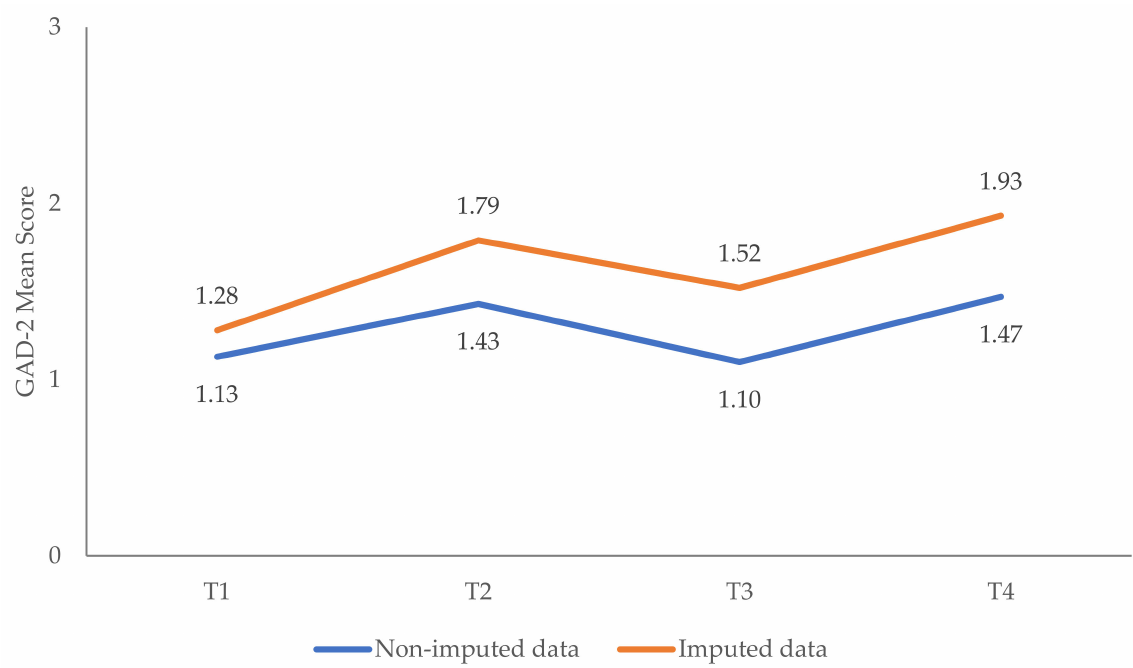
Figure A3. Changes in symptoms of anxiety (GAD-2) over time: imputed vs. non-imputed results. Note: Imputed dataset: n = 1001. Non-imputed dataset: n =